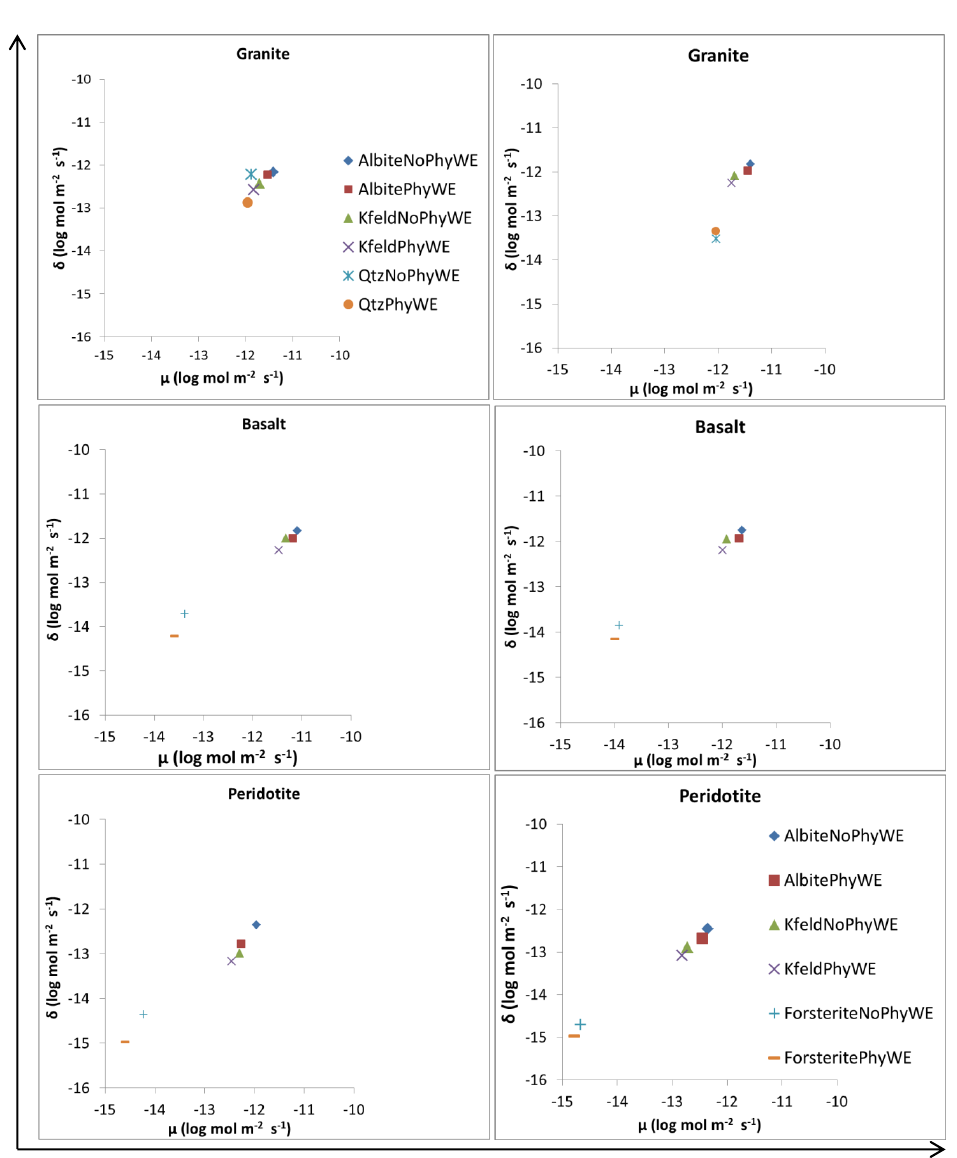
Figure 7. Sensitivity of mineral dissolution rates to physical weathering (Model A) and to other interactive soil-forming processes (Model B). The data used in this sensitivity analysis were extracted from the top soil compartment (0.05m depth). µ and δ are the mean and standard deviation, respectively of elementary effects ( u i ) calculated from Eq.